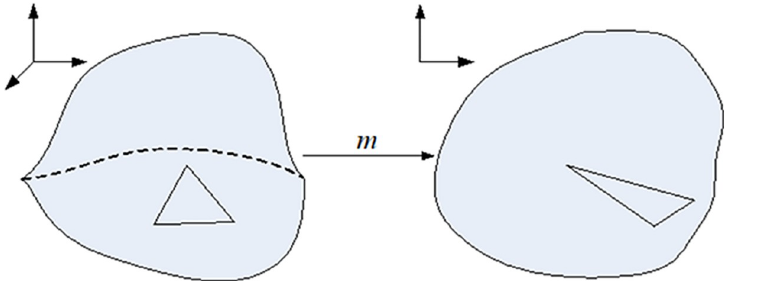
Fig 5. Illustration of the initial boundary-fixed conformal parameterization.